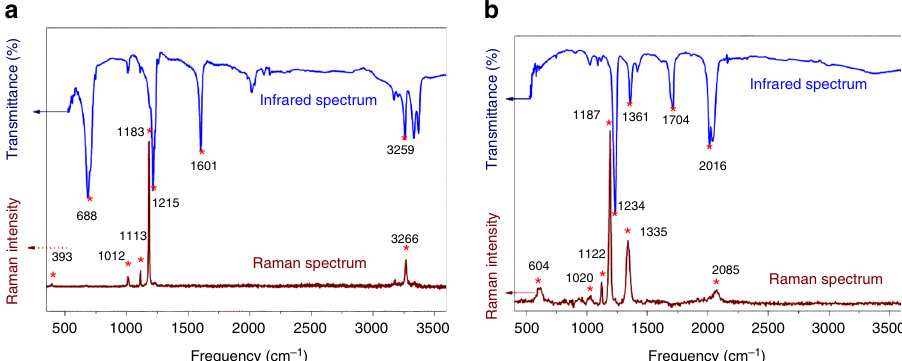
Fig. 5 Vibrational spectra. a Infrared and Raman spectra of solid [Ag(NH 3 ) 2 ] + [Ag 3 (N 5 ) 4 ] ˉ . b Infrared and Raman spectra of the solid AgN 5 complex. The red asterisks stand for the position of peak